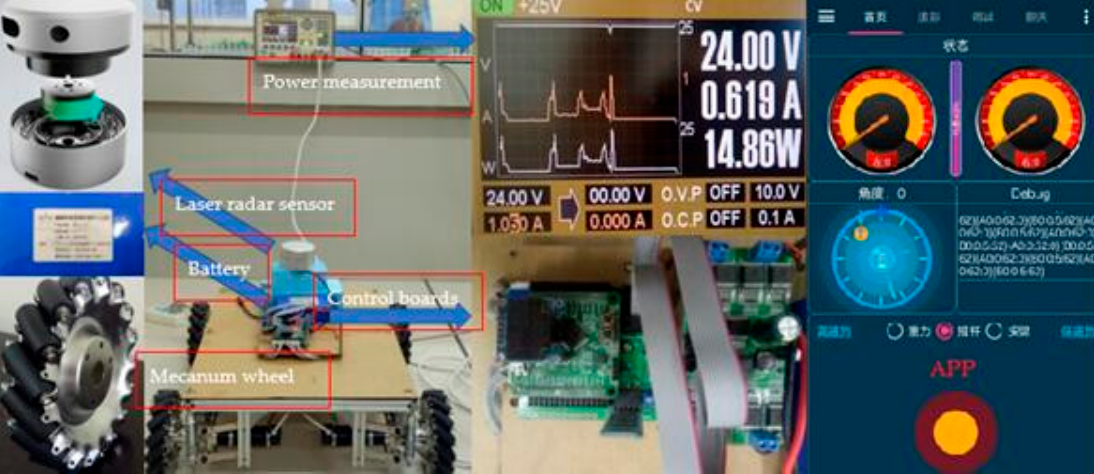
Figure 5. Four ‐ wheel ‐ drive Mecanum mobile robot and power measurement. Figure 5. Four-wheel-drive Mecanum mobile robot and power